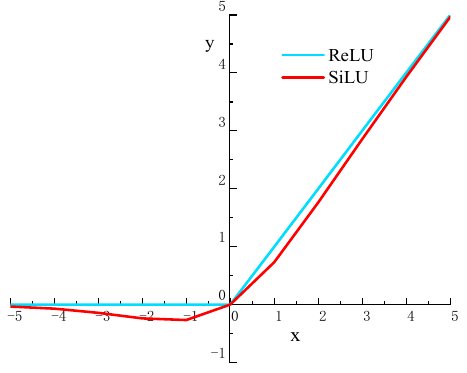
Figure 6. Function image comparison.